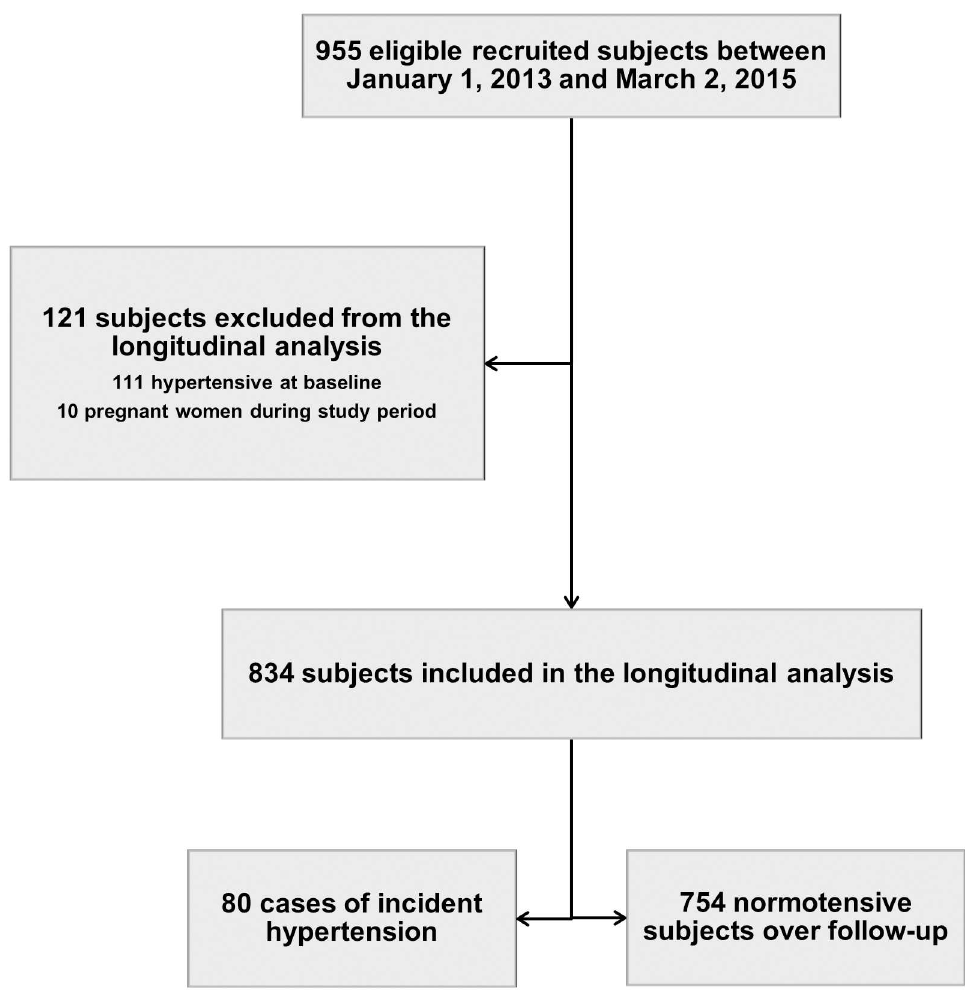
Fig 1. Patient flow